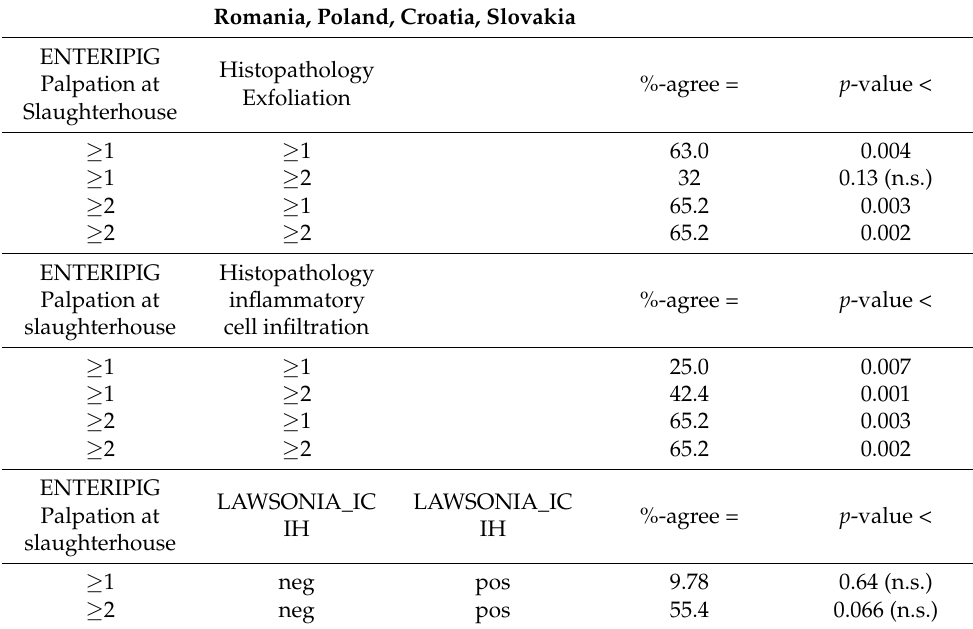
Table 7. Cohen’s analyses of VP and